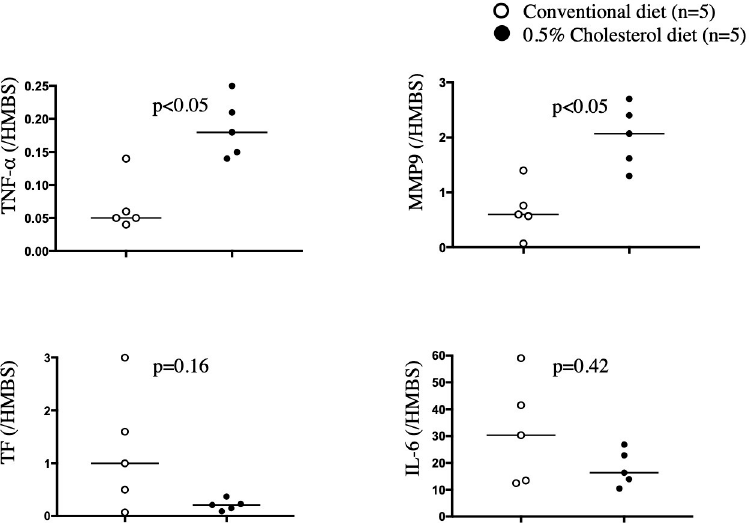
Fig 2. TNF- α , MMP9 , TF , and IL-6 mRNA levels in the neointima of injured arteries. Neointimal RNA from rabbit iliofemoral arteries was isolated and reverse transcribed into cDNA. qRT-PCR was performed for interleukin (IL)-6 , matrix metalloproteinase (MMP) 9 , tissue factor (TF) , tissue necrosis factor (TNF)- α , and hydroxymethylbilane (HMBS) . Target gene expression levels were normalized to those of HMBS . Neointimal TNF- α mRNA level in the conventional diet group (0.07 ± 0.04) or the 0.5% cholesterol diet group (0.2 ± 0.04). Neointimal TF mRNA levels from the conventional diet group (1.2 ± 1.0) or the 0.5% cholesterol diet group (0.2 ± 0.09). Neointimal MMP9 mRNA levels from the conventional diet group (0.7 ± 0.4) or the 0.5% cholesterol diet group (2 ± 0.5). Neointimal IL-6 mRNA level in the conventional diet group (31.3 ± 17.6) or the 0.5% cholesterol diet group (18 ± 6). Data are represented as mean ± standard deviation, and individual data points and median for each group. Data were analyzed using Mann- Whitney U tests.